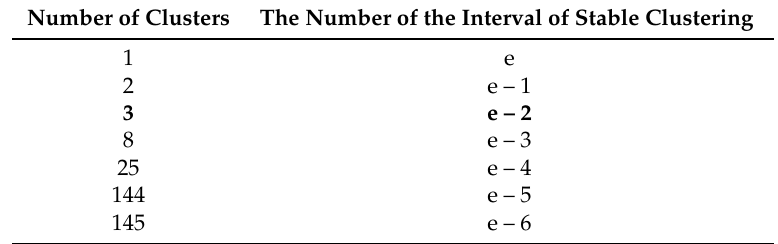
Table 2. The number of clusters received for the iris dataset by application of the e-2 hypothesis.